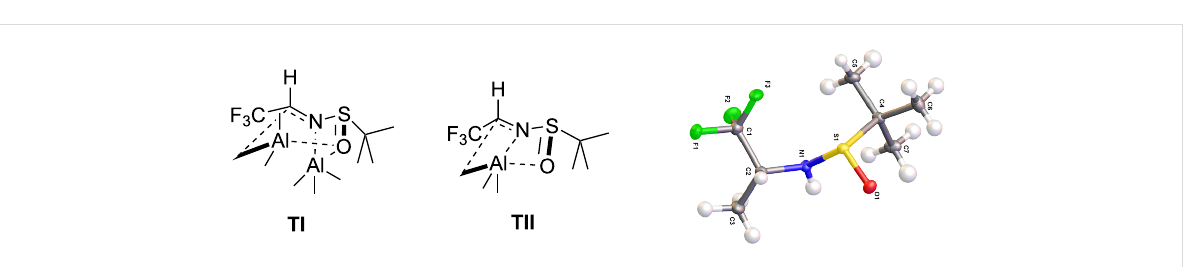
state TI . As in this case almost quantitative conversion